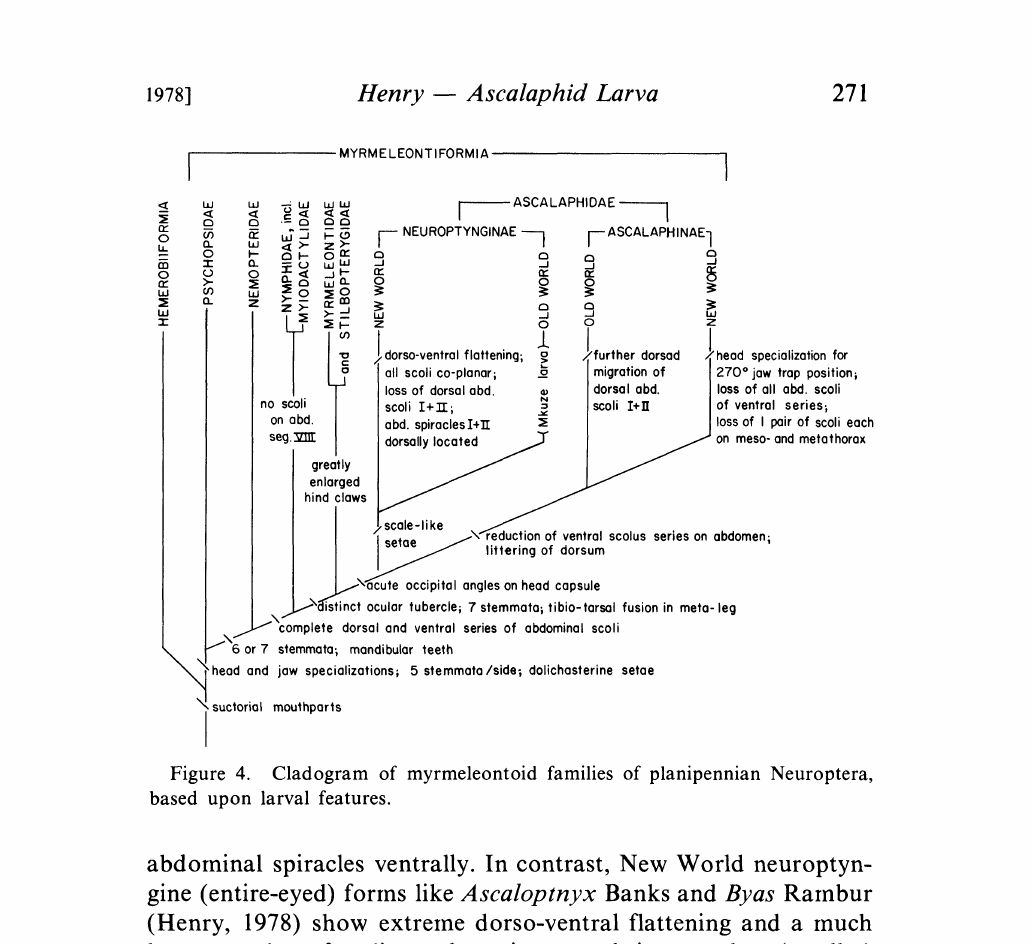
Figure 4. Cladogram of myrmeleontoid families of planipennian Neuroptera, based upon larval features. abdotninal spiracles ventrally. In contrast, New World neuroptyn- gine (entire-eyed) fortns like Ascaloptnyx Banks and Byas Ratnbur (Henry, 1978) show extreme dorso-ventral flattening and a tnuch larger nutnber of scoli--twelve pritnary and six secondary (stnaller) pairs, the latter placed just anteriad of the fortner on abdotninal segtnents III-VIII. In addition, abdotninal spiracles I and II are dorsally located in these neuroptyngines, and specialized scale-like dolichasters predotninate on their body surfaces. Known Old World both a dorsal and ventral series of scoli on the abdotnen and laterally located abdotninal spiracles; however, at least in Ascala- phus Fabricius, the ventral series is largely vestigial and the first Tjeder (1972) points out that Ascalaphus as used here and as previously understood should be replaced for nomenclatural reasons by Libelloides Schiffer; Ascalaphus Fabricius then replaces Helicomitus